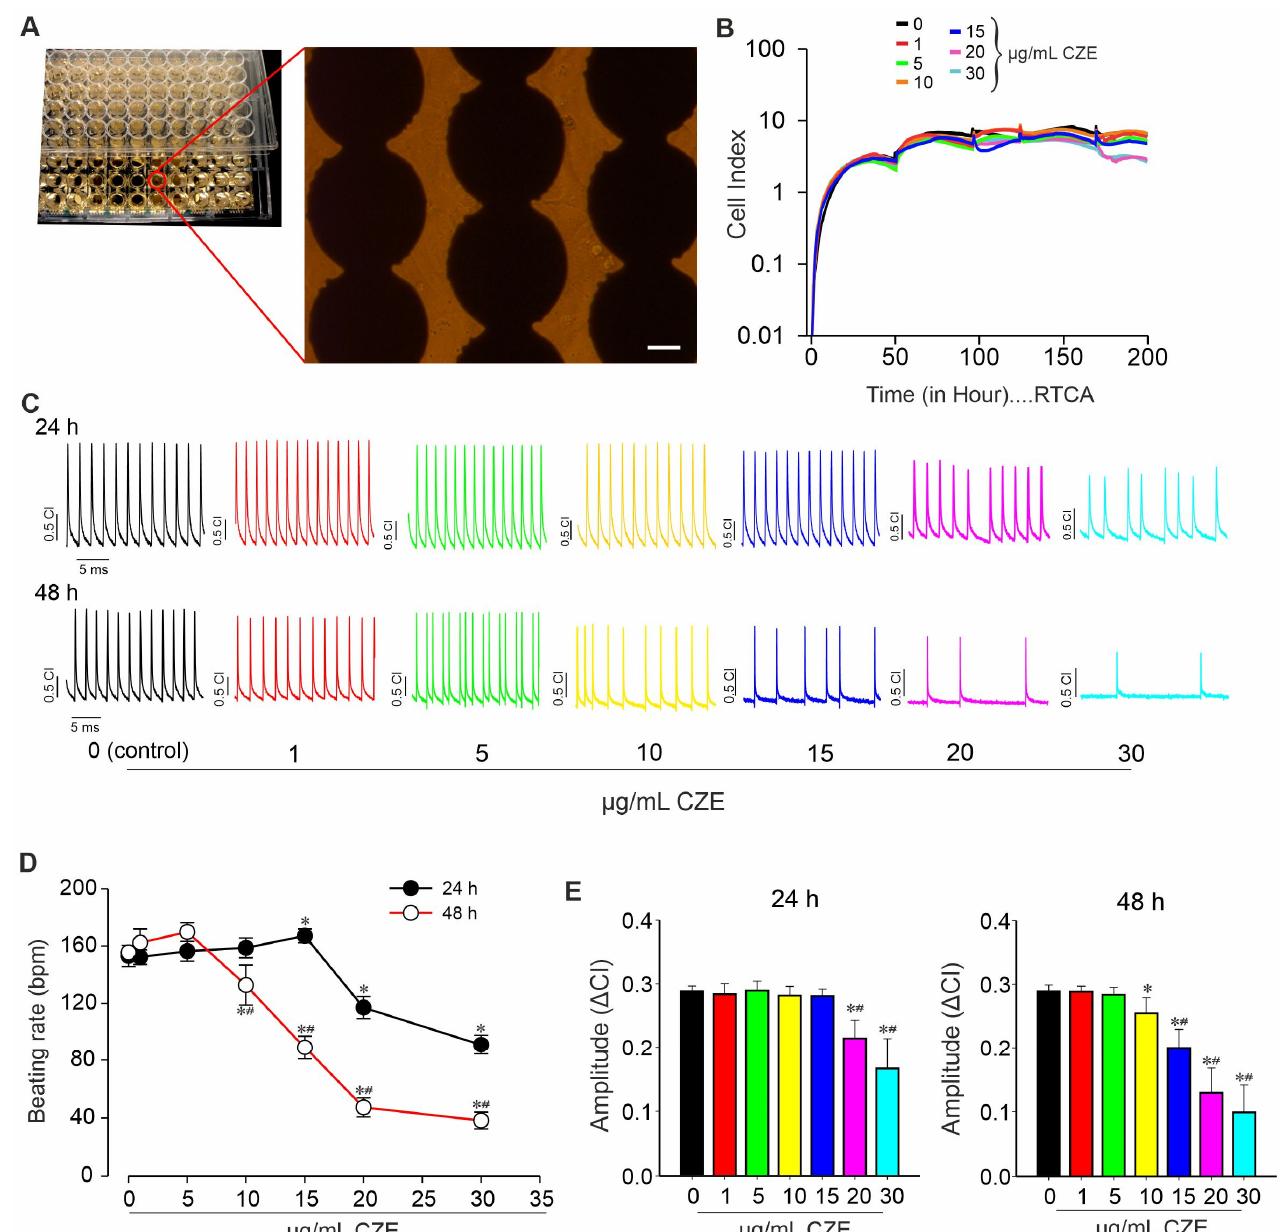
Figure 4. Effect of Crinum zeylanicum extracts (CZE) on cell index (CI) and spontaneous contractile activity of miPSC-CMs using xCELLigence RTCA Cardio System. ( A ) Representative images of a part of E-Plate Cardio 96 and zoomed in of a well containing monolayer of spontaneously beating iPSC-CMs growing on microelectrodes. ( B ) Representative graph from one of three independent experiments showing the effects of CZE extract on miPSC-CMs. The CI was monitored in real time for about 200 h after addition of 0 (control), 1, 5, 10, 15, 20, and 30 µg/mL CZE. ( C ) Representative beating rate pattern of 20 ms recordings of miPS-CMs 24 h (upper panel) and 48 h (lower panel) with various concentrations of CZE. ( D , E ) Average change in beating rate ( D ) and in the amplitude (delta CI) ( E ) of beating signals of iPSC-CMs under different concentrations of CZE. Asterisks indicate results that show significant difference from control by Student’s t- test. Scale bar = 50 µm. Results are reported as the mean ± SEM ( n = 3 independent experiments). * and # ( p < 0.05, Student’s t- test) indicate results that show significant difference from control (untreated) and from previous concentrations, respectively.